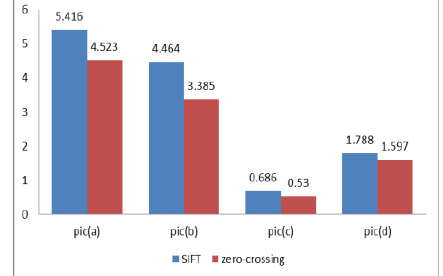
Figure 3(d) time(second) of feature extraction by SIFT algorithm and zero-crossing algorithm. Blue bar for SIFT algorithm and red bar for zero-crossing algorithm. The x-axis showed different group of test images and the y-axis stands for the time of feature extraction.